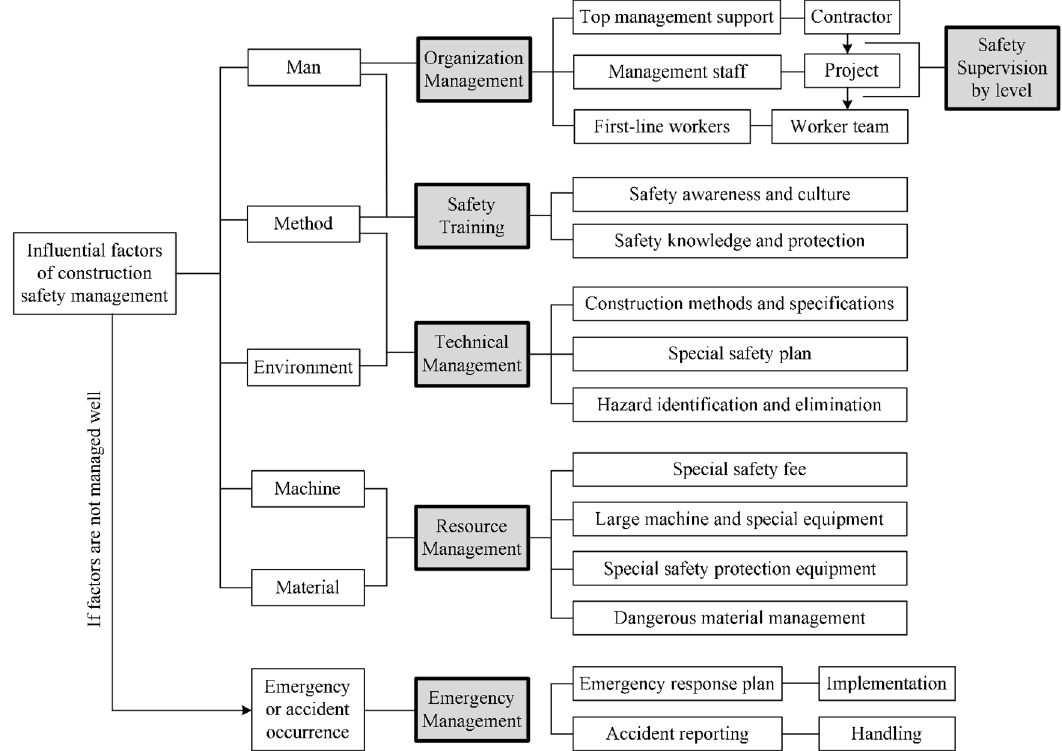
Figure 1. Structure of system thinking of construction safety